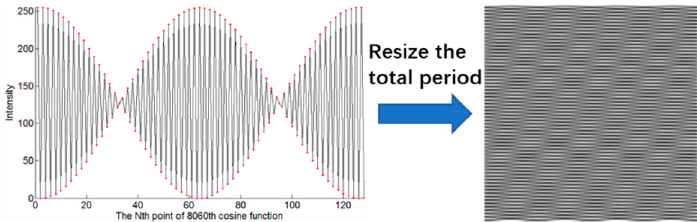
Figure 3. The resolution of the resulting image is 128 128 Figure 3. Reconstructed images and RMSE with different sampling ratios in the numerical simulation. Figure 3. Reconstructed images and RMSE with di ff erent sampling ratios in the numerical simulation. Sensors 2020 , 20 , x FOR PEER REVIEW